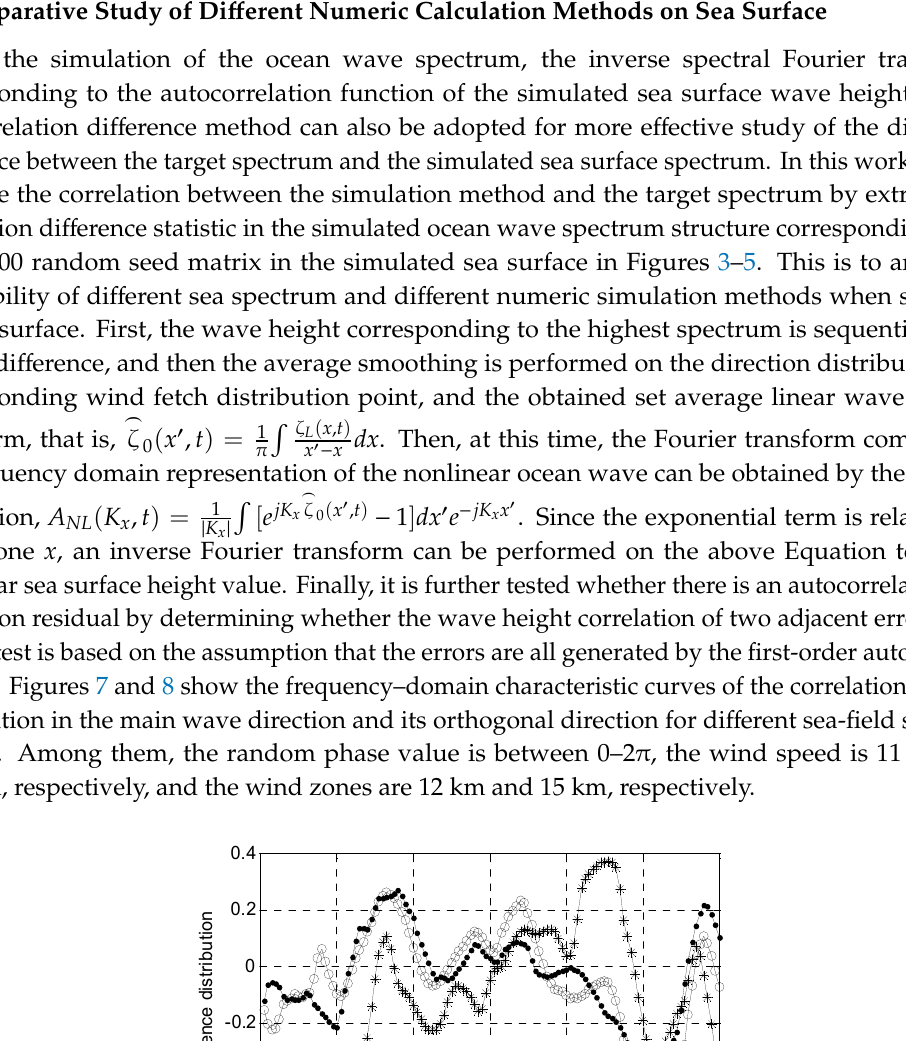
. Figure 8. Correlation difference distribution of Fractal method. Based on the frequency domain characteristics of the correlation difference distribution in the main wave direction and the orthogonal direction of the above different sea-field simulation models, this study analyses the similarity between the simulated sea surface and the target spectrum by analyzing the wave height energy distribution of different numeric calculation methods in the 320° direction. Among them, the default random phase value is between 0–2 π , the wind speed is 11 km/h, and the wind fetch is 15 km. At this time, the sea surface is fully developed. The distribution results are as follows (Figures 9 and 10),